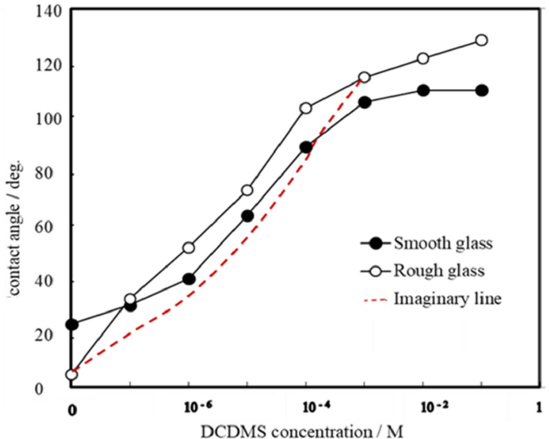
Figure 3. Dynamic contact angle of water droplets on smooth (filled symbol) and rough (opened symbol) surfaces glass slides before hydrophobisation with DCDMS (0 M) and when gradually hydrophobised through serial concentrations of DCDMS. Imaginary (dashed) line shown in the plot represents the hypothetical curve for Wenzel rough surface.